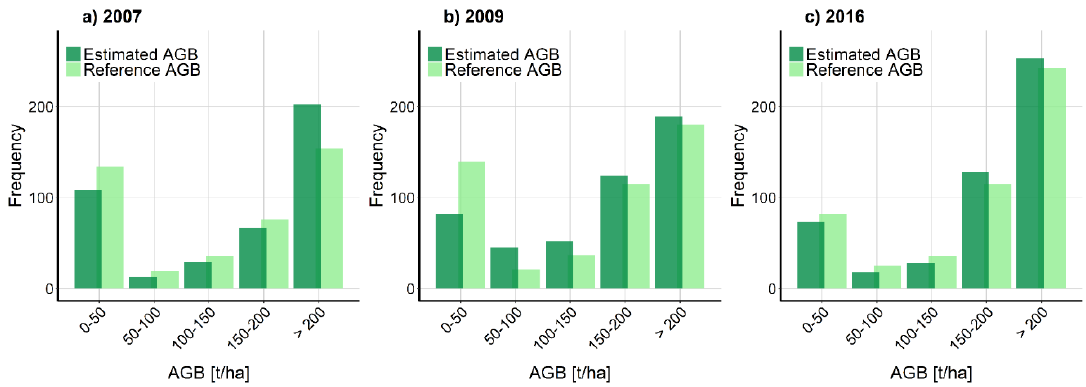
Figure 7. Histograms of reference above-ground biomass and estimated above-ground biomass per biomass range for each year. Frequency refers to the number of observations per range.